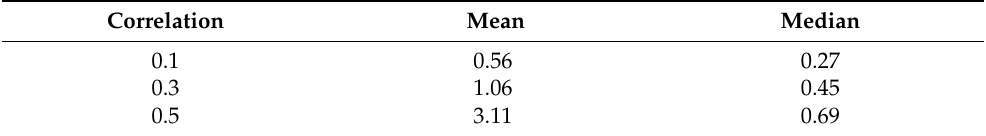
Figure 3. R 2 after DP-BCD as a function of the correlation between predictors in the data-generating model. Table 4. Mean and median proportional absolute error over the correlation between predictors.